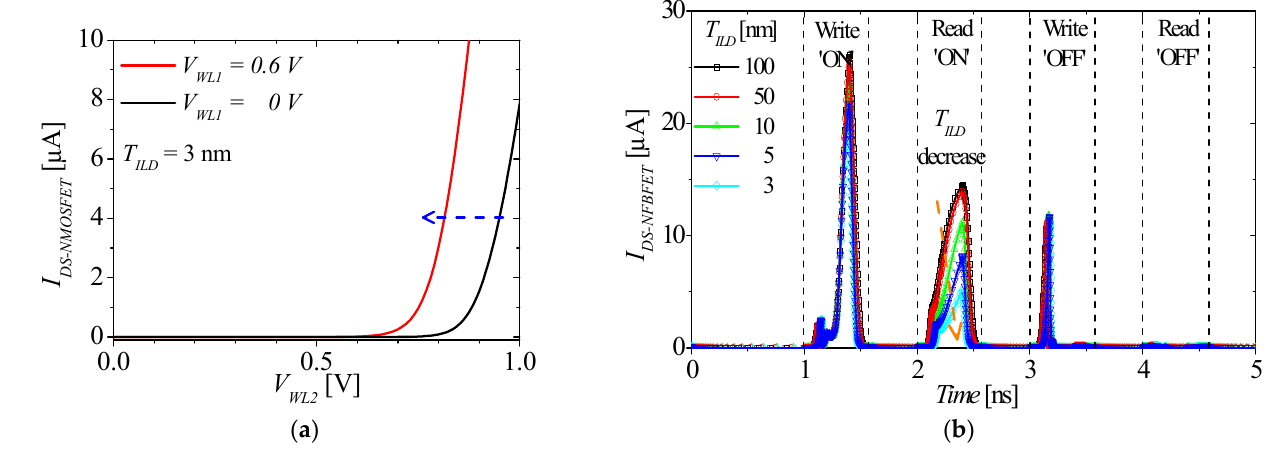
Figure 7. ( a ) Changing threshold voltage at two different bottom transistor gate voltages ( V WL1 = 0 and 0.6 V) at T ILD = 3 nm. ( b ) The M3D − FBFET − SRAM cell operation with respect to various T ILD .